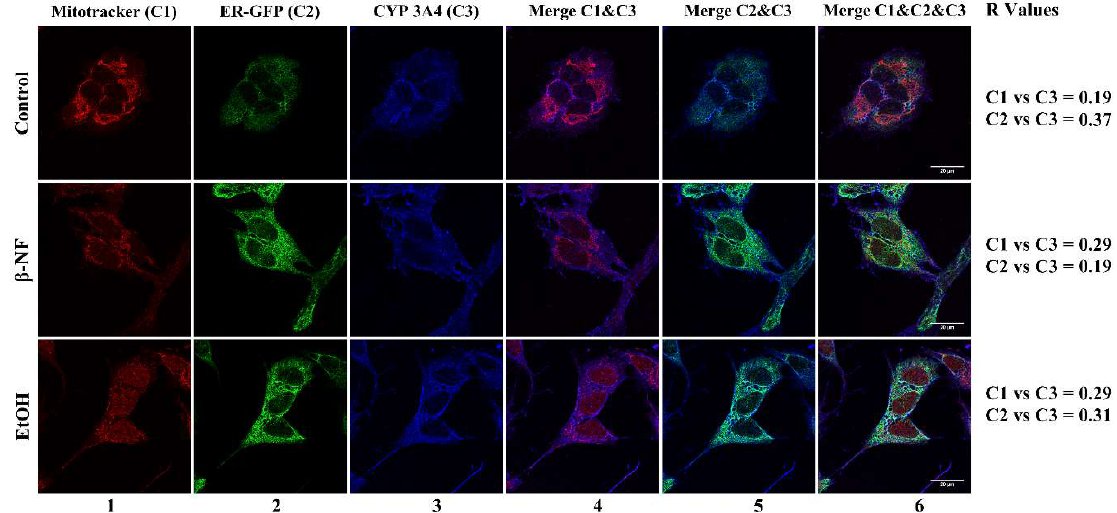
treatments were 0.29, while the values obtained in ER were 0.19 and 0.31, respectively.